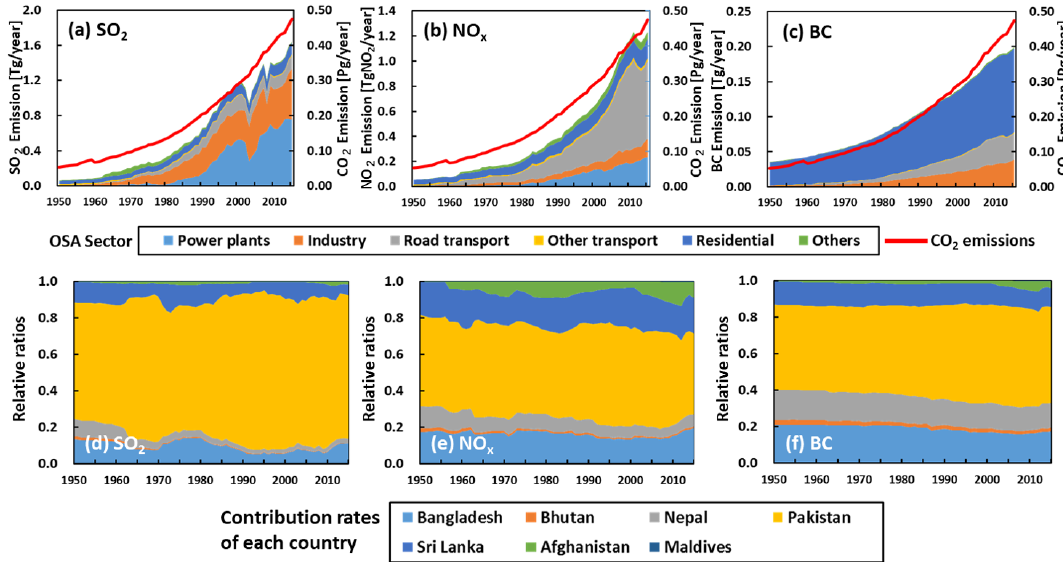
Figure 7. Emissions of (a) SO 2 , (b) NO x , and (c) BC from each major sector in OSA (a, b, c) and (d, e, f) relative ratios of emissions from each country in OSA (d, e, f) from 1950 to 2015. Red lines in the upper panels are total CO 2